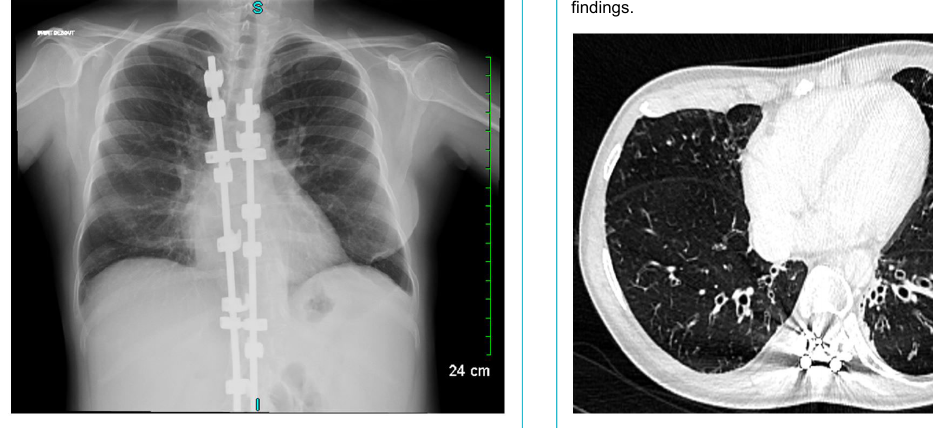
Figure 1: Chest X-ray showing scoliosis with spinal osteosynthe- sis and images of bronchiectasis.